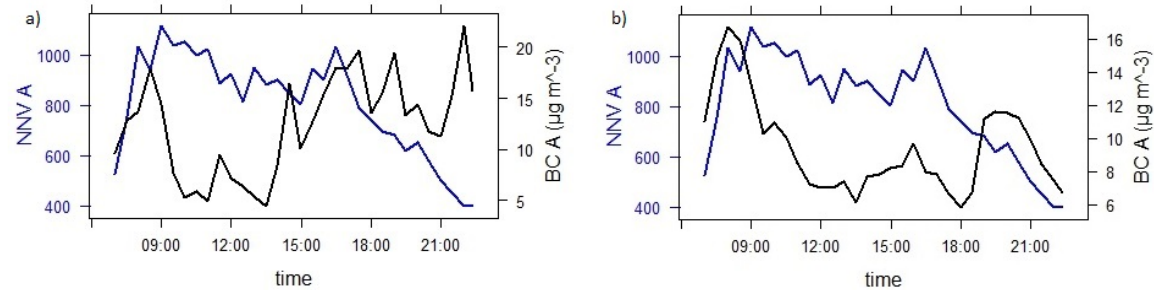
Figure 5. BC concentrations in dependence to normalized number of vehicles (NNV) in winter ( a ) and spring ( b ) time at measuring point A.